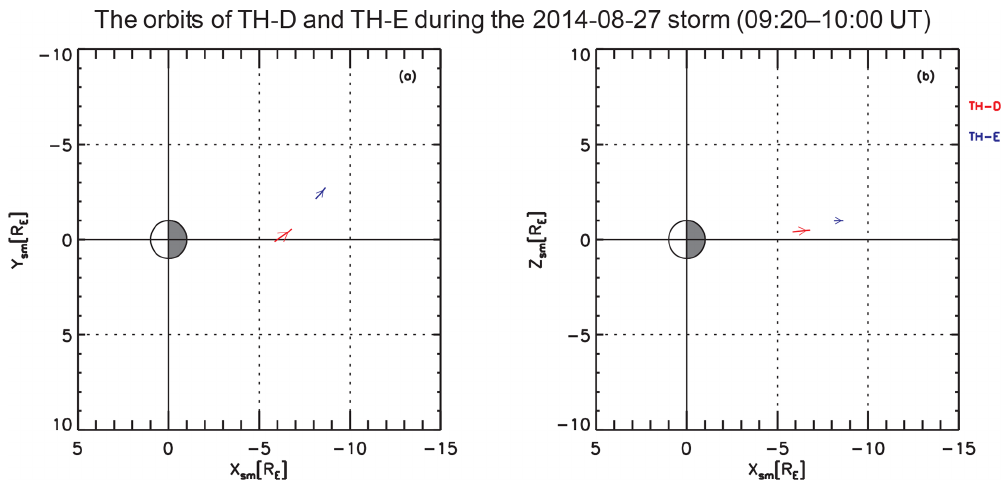
Figure 2. The orbits of TH-D and TH-E in the X − Y SM plane and the X − Z SM plane from 09:20 to 10:00UT on 27 August 2014, which were in the nightside magnetosphere. The arrow shows the flying direction of the satellites. TH-D is red and TH-E is blue.